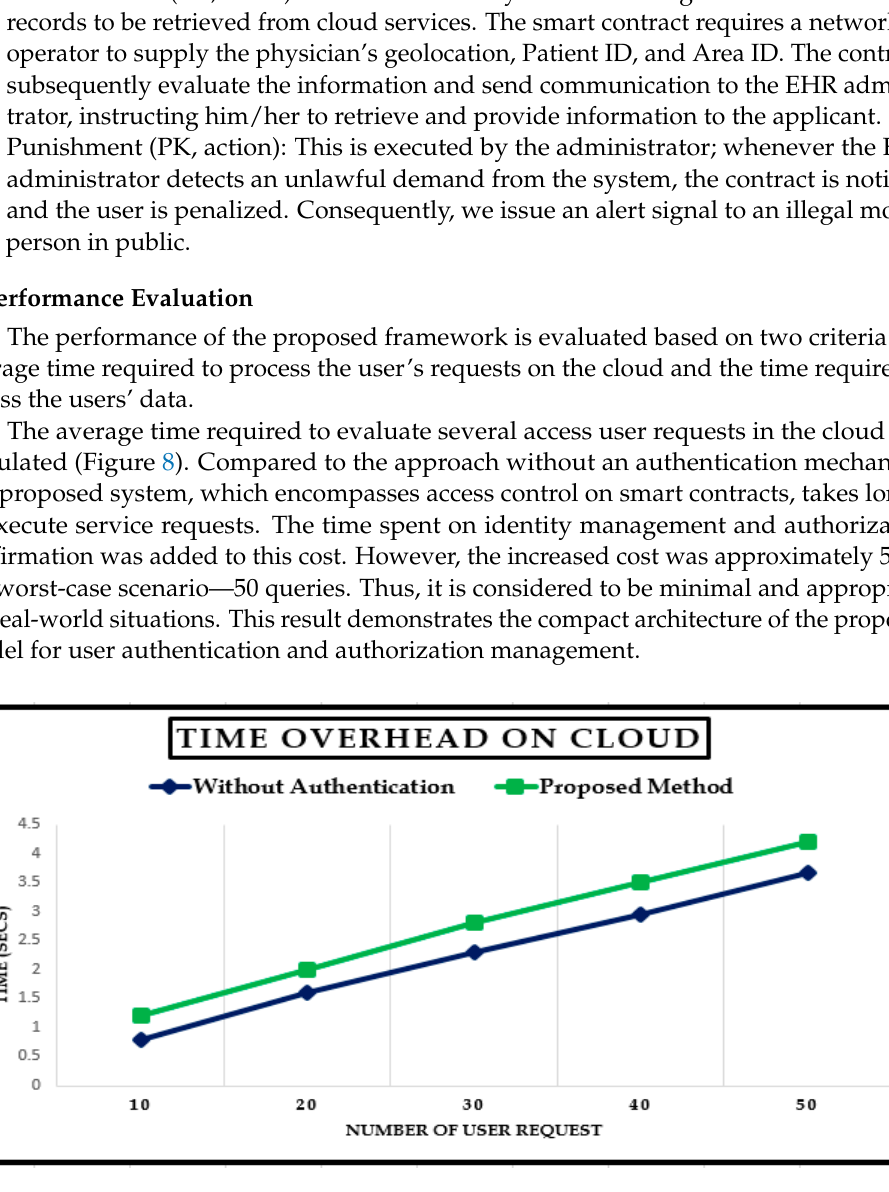
Figure 9. Time Required to Access the Data on the Cloud versus the Blockchain.